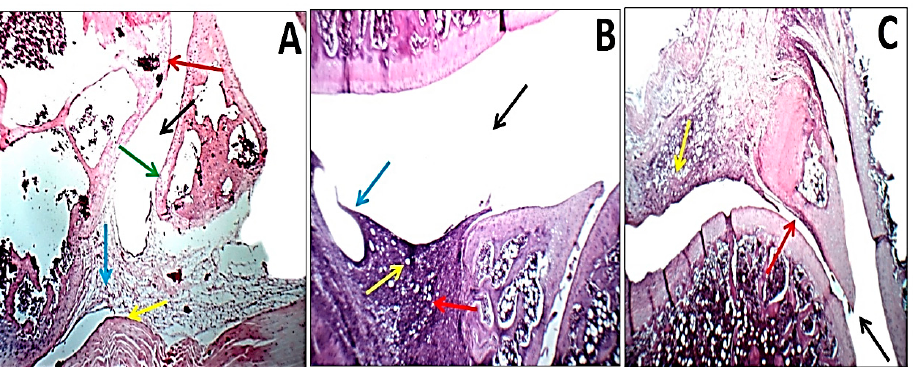
Figure 12. Photomicrographs of H&E-stained sections illustrating the impact of Nano ZT/Vit B12 on histopathologic changes in the ankle joints of arthritic rats. In normal control rats ( A ), the joint shows the average joint cavity (black arrow), average synovial lining (blue arrow), average sub- synovial tissue (yellow arrow), average articular cartilage with intact superficial layer (red arrow), and average menisci (green arrow). Joints of arthritic rats ( B ) show an average joint cavity (black arrow), destructed pannus on the menisci (red arrow), villous formation of synovial lining (blue arrow), and a significant sub-synovial inflammatory infiltrate (yellow arrow). In arthritic rats given Nano ZT/Vit B12 ( C ), the joints had an average joint cavity (black arrow), a small pannus on the menisci (red arrow), and a mild sub-synovial inflammatory infiltrate (yellow arrow) (H&E X 100). Table 2. Ankle histological lesion scores in the normal control, arthritic, and arthritic with Nano ZT/Vit B12 groups.